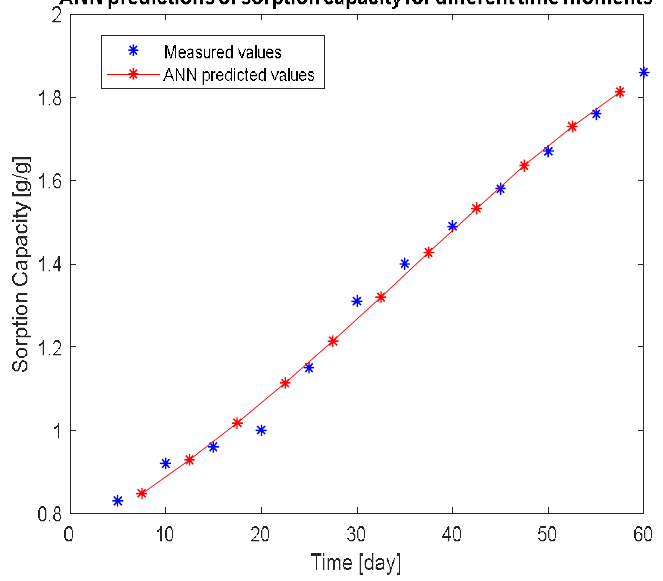
Figure 6. ANN predictions of the sorption capacity at different time intervals for shungite and rice husk at a ratio 1:1.7 and for the 10% oil-contaminated soil .